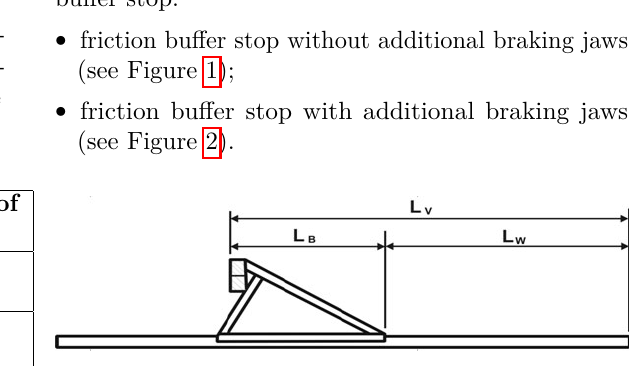
Figure 1. Friction buffer stop